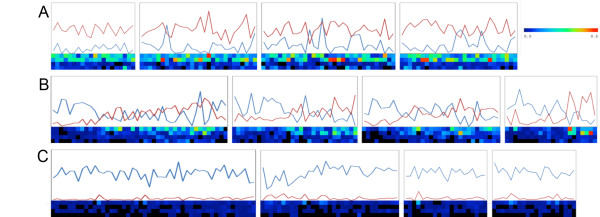
Distribution of genes and transposable elements in representative scaffolds. A) TE-rich scaffolds (scaffolds 380, 50, 29 and 127), B) Scaffolds with similar proportions of TEs and genes (scaffolds 33, 222, 151 and 132), C) Gene-rich scaffolds (123, 464, 898 and 605). The line graphs represent the proportional coverage (scale of 0.0 to 1.0) of TEs (red) and genes (blue) in 50kb windows. Each heat map row below each graph represent coverage of the four largest TE superfamilies – top to bottom: Copia, Gypsy, L1, Mutator, in 50kb windows (squares).